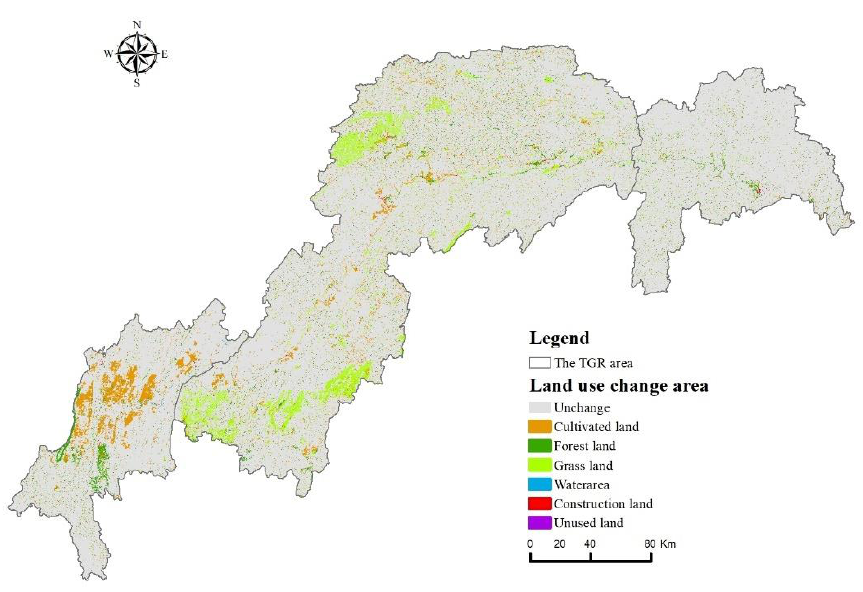
Figure 9. HQ index values before and after land use type change from 2000 to 2020.